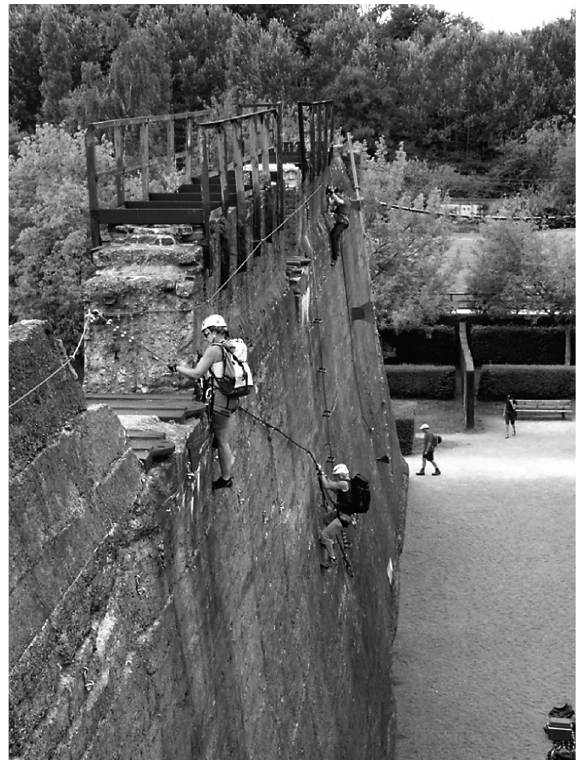
Fig. 4. Landscape Park Duisburg-Nord: a climbing garden (photo by M. Otto,